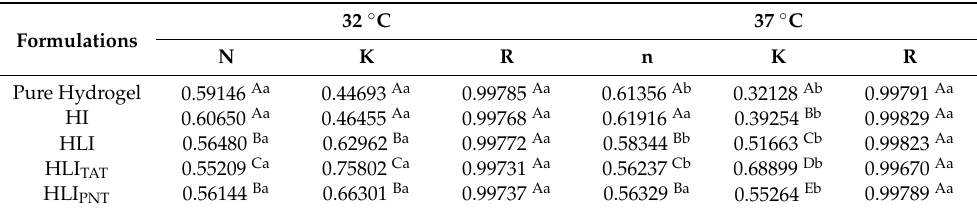
Table 1. Flow index (n) and consistency index (k) and linear regression (R) values at 32 ± 0.5 ◦ C and 37 ± 0.5 ◦ C (n = 3).